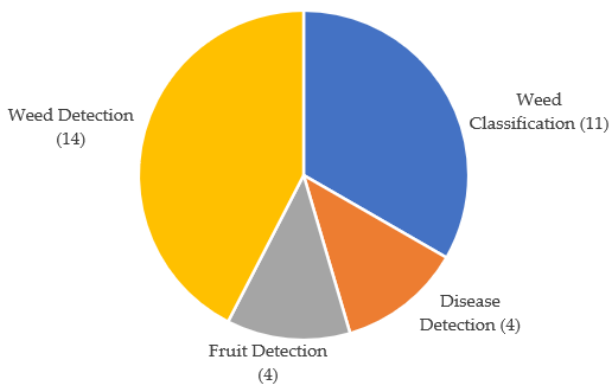
Figure 2. Number of articles published by year (Year; Number of publications).